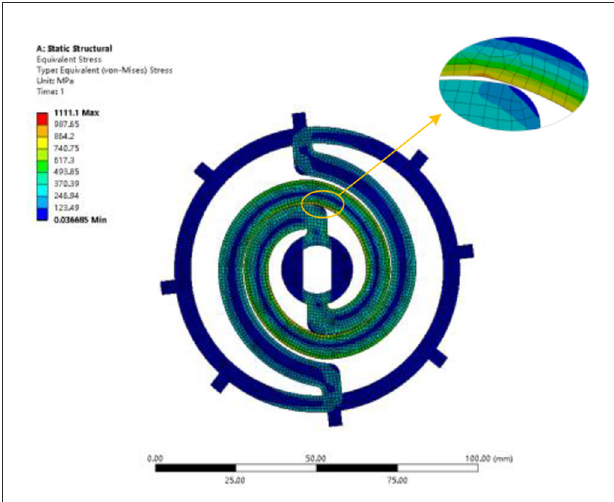
FIGURE8 Static structure analysis of the optimal coupler.